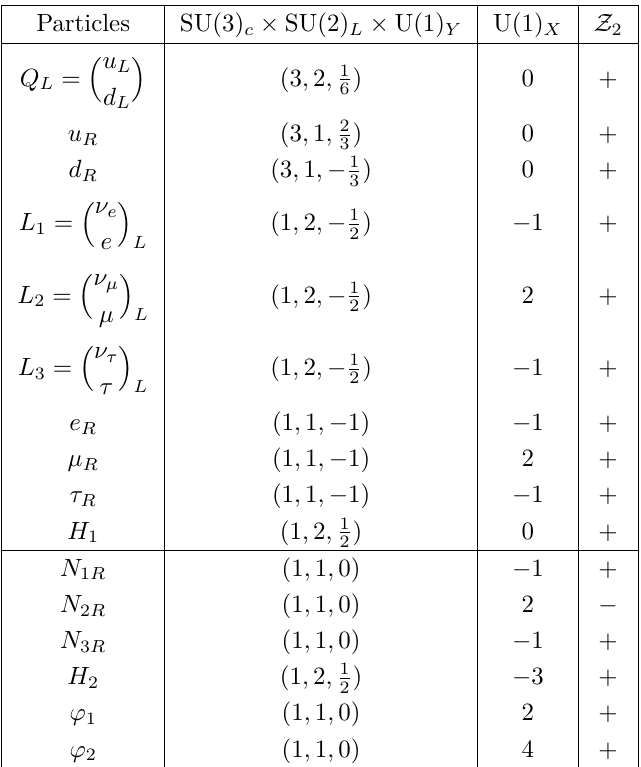
Table 4 . Particle content for Toy Model